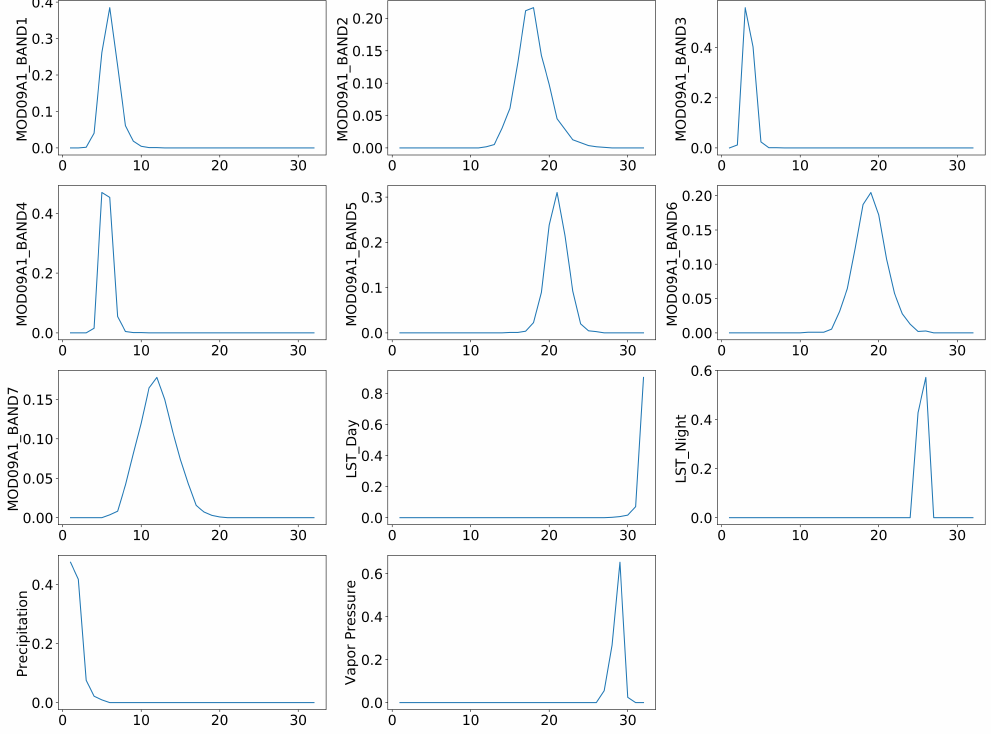
Figure A3. One time-step of tensors for Marion in Kansas, Aug 21st 2011.